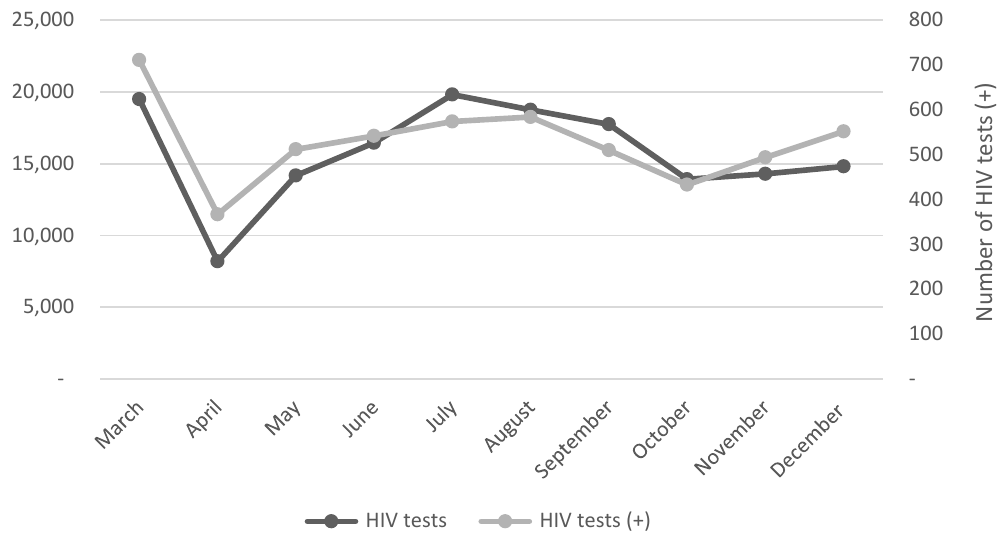
Figure 3. Line graph presenting the monthly numbers of HIV tests and positive HIV tests (+) for adults over 15 years of age in 2020. The number of positive HIV tests follows the trend of the number of HIV tests being conducted. A significant decrease in both testing and positive tests was seen for the month of April, coinciding with the start of lockdown level five. A monthly increase in testing and positive tests was seen throughout the year, however, it did not increase to the pre-lockdown level. This figure was created using data from Mutyambizi et al., 2021 [26]. (HIV = Human Immunodeficiency Virus). HIV testing and HIV tests (+) for children < 15 years